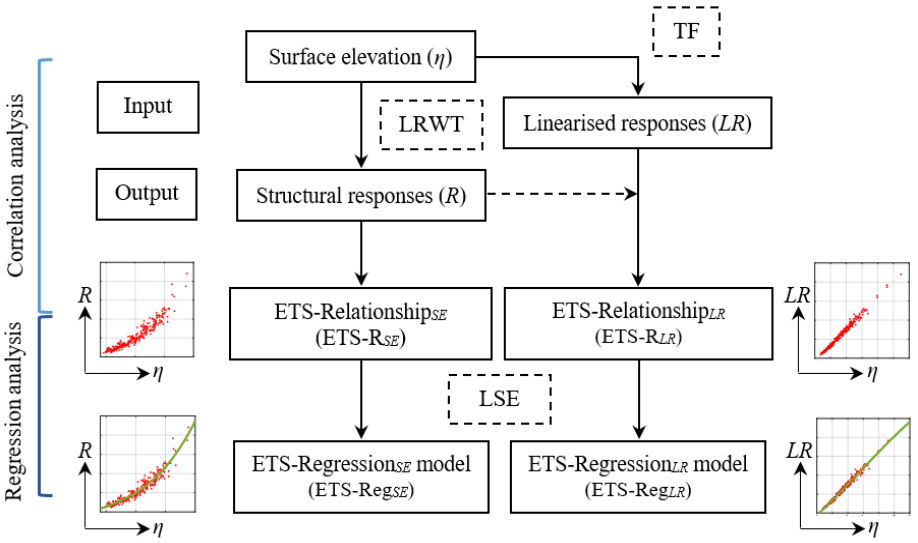
Figure 3. Assessment the relationship using Pearson’s correlation–regression analysis.